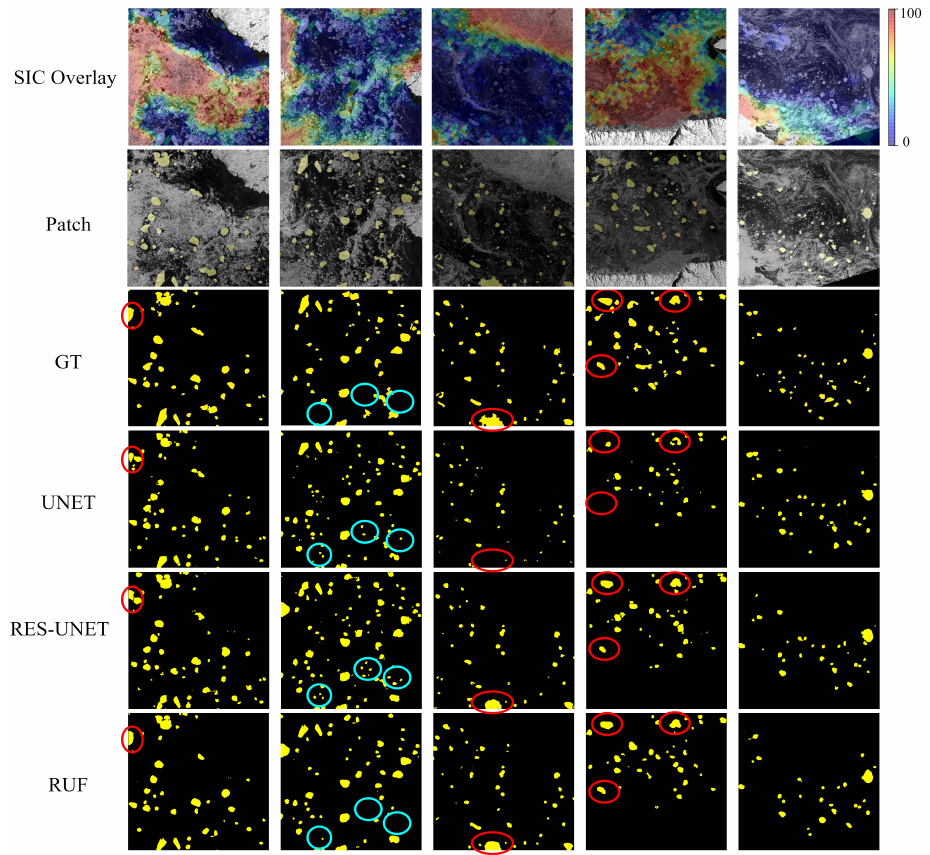
Figure 7. Comparison between the predictions of UNET, RES-UNET, and RUF for the task of ice floe segmentation on patches from the test set. Red ovals highlight segmentation results where both UNET and RES-UNET are unable to properly segment a fully or partially visible ice floe. Blue ovals highlight segmentation results where both UNET and RES-UNET produced many false-positive predictions. It can be observed that the proposed RUF architecture is able to produce finer segmentation results compared to other backbone architectures on our dataset. Here, Patch and GT denote original image patch input and ground truth, respectively. The sea ice concentration (SIC) masks are overlaid on the respective patches for comparison between sea ice as continuous (passive microwave data) vs. discrete (processed ice floe masks from SAR)